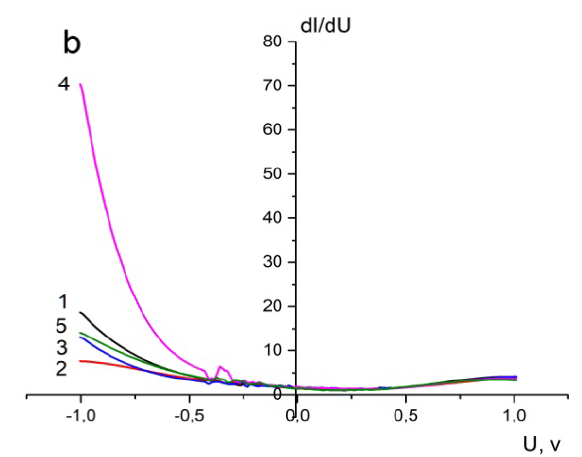
Figure 4. Differential conductance versus applied voltage, measured at points along the edge of the step (a) and along the normal to the edge of the step (b).